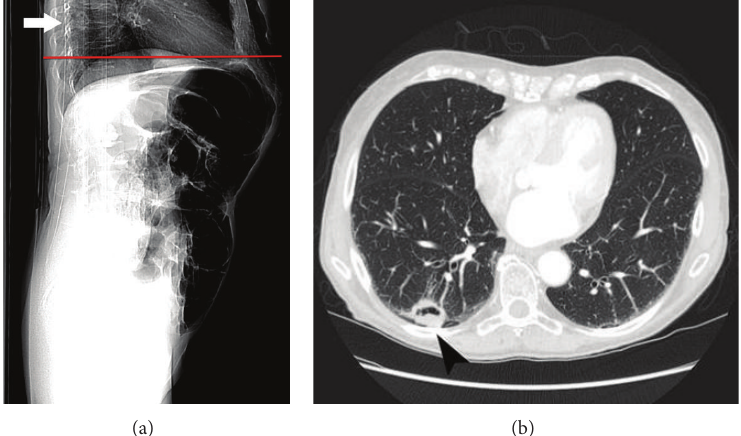
Figure 3: (a) CT scout (AP) view demonstrates a solitary cavitating nodule posteriorly within the right lower lobe (white arrow). The level of the first axial image from the CT colon study is shown by the red line, demonstrating that the scan commenced below the level of the lesion. (b) A selected image from the chest component of the subsequent CT examination demonstrates a cavitating soft tissue attenuation nodule within the posterior basal segment of the right lower lobe (black